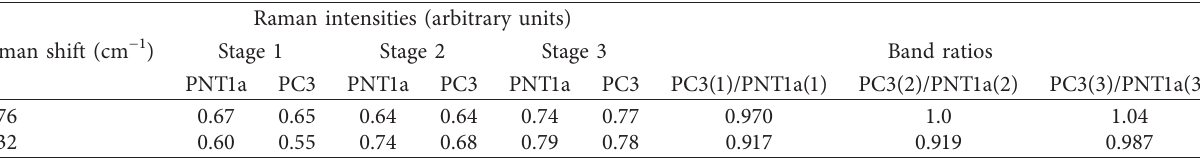
Table 6: Comparison of band intensity ratios between malignant (PC3) and normal cells (PNT1a) based on the weak Raman bands at 1076cm − 1 and 1232cm − 1 . Raman intensities (arbitrary units) Raman shift (cm − 1 ) Stage 1 Stage 2 Stage 3 Band